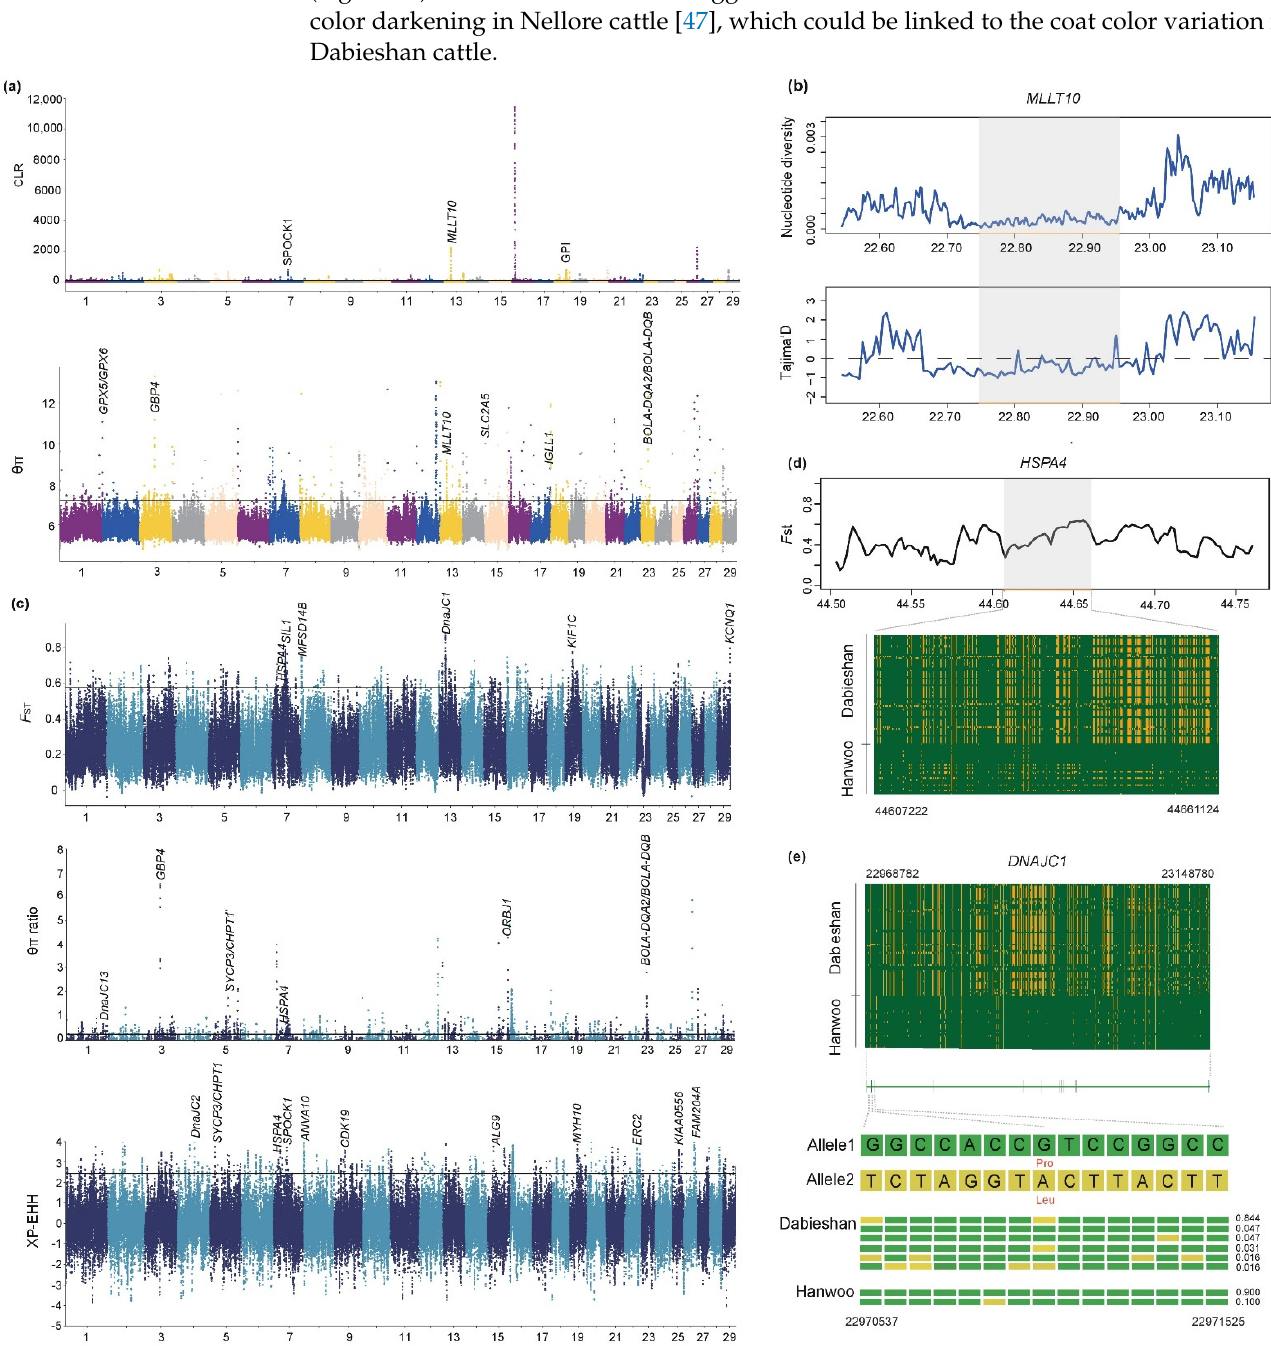
Figure 3. The signatures of selective sweep in Dabieshan cattle. ( a ) Manhattan plot of CLR and θπ for the autosomes. The line indicates the threshold line for the top 1% region ( b ) The line chart of nucleotide diversity and Tajima’s D at the MLLT10 gene region. ( c ) Manhattan plot of F ST , θπ -ratio and XP-EHH based on Hanwoo. ( d ) F ST and haplotype sharing at the HSPA4 gene region. ( e ) The haplotype patterns heatmap and structure of DNAJC1 with exons indicated by vertical bars. A missense mutation was highlighted in